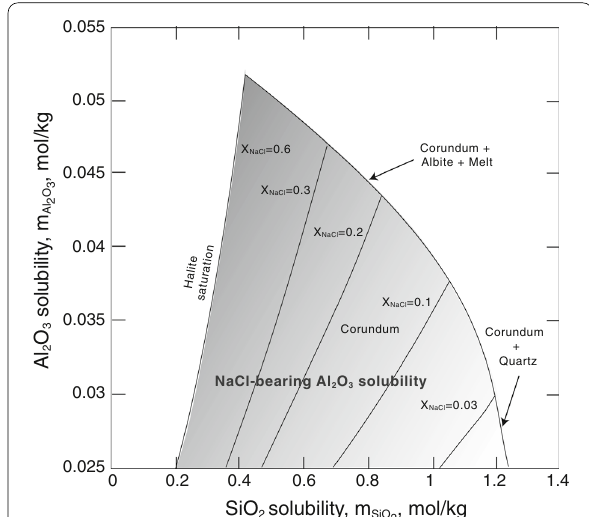
Fig. 20 Phase relations in the Al 2 O 3 –SiO 2 –H 2 O–NaCl in terms of Al 2 O 3 and SiO 2 solubility at 1 GPa and 800 °C. The lines denoted 0.03, 0.1 etc., are NaCl isopleths calculated from the expression with individual NaCl isopleths calculated from Eq. (18). Modified after Newton and Manning (2008)